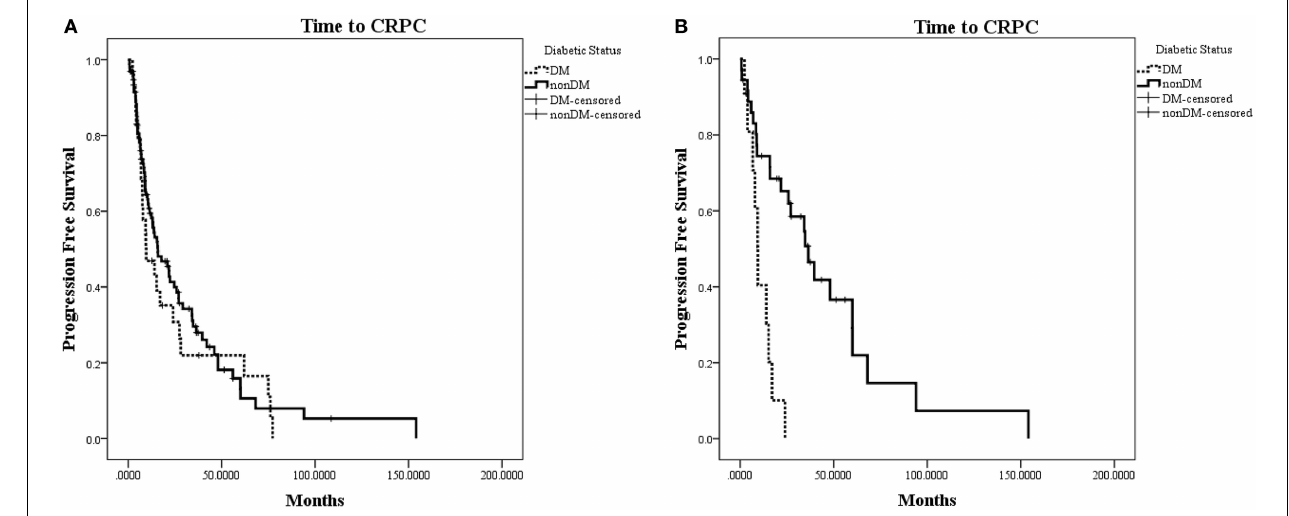
metastases ( N = 47). Patients with diabetes in this subset were observed to progress to CRPC significantly faster than patients without diabetes (HR for progression with diabetes = 4.58; 95% CI: 1.92–10.94; p =